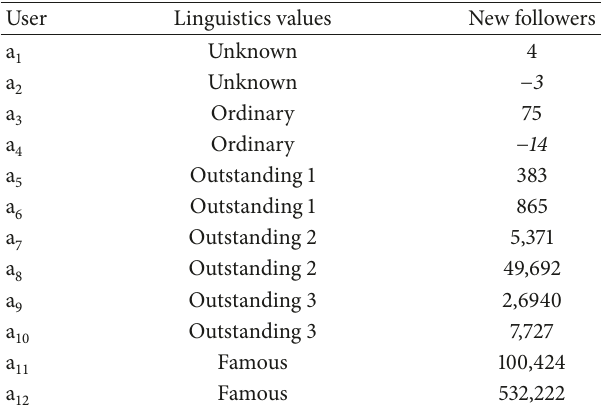
Table 2: Growth in number of